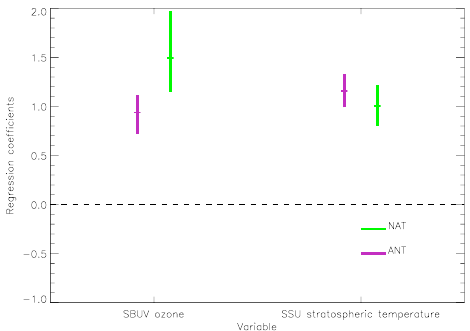
Fig. 6. Regression coefficients of observed changes in SBUV strato- spheric ozone mixing ratio (left) and SSU stratospheric tempera- ture (right) onto the simulated responses to anthropogenic forcings (ANT) and natural forcings (NAT). The ANT response was derived from the REF-B2 output. Results are based exclusively on those models in which a QBO was assimilated (CCSRNIES, SOCOL and WACCM). Bars represent 5–95% uncertainty ranges. SBUV results are based on nine 3-yr means over nine 20 ◦ zonal bands on eleven levels, and SSU results are based on nine 3-yr means over fifteen 10 ◦ zonal bands on three levels, and both use a representative EOF truncation of